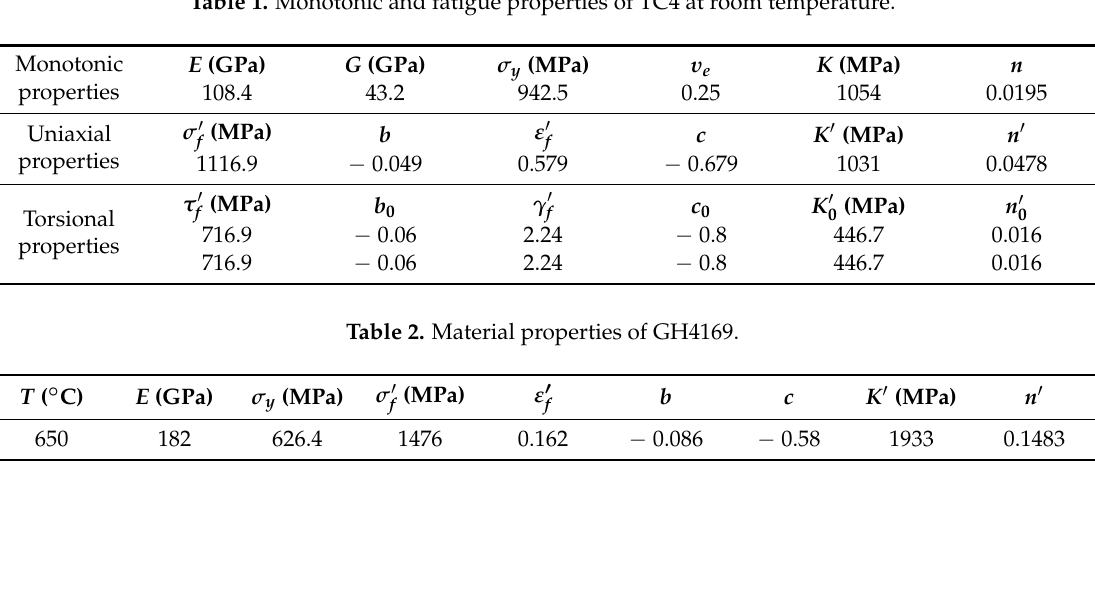
Table 1. Monotonic and fatigue properties of TC4 at room temperature.